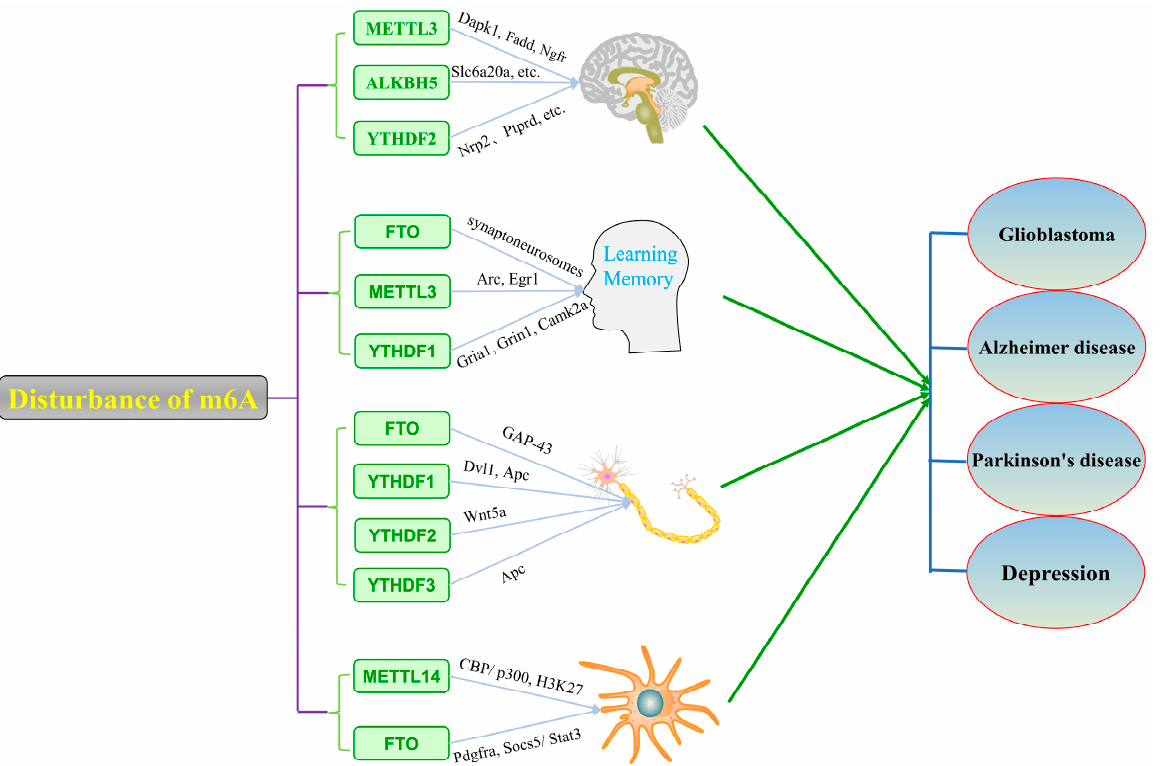
Figure 2. Disorders of m6A modification leads to dysfunction of the central nervous system and related diseases. Abbreviations: Slc6a20a (Solute carrier family 6 (neurotransmitter transporter), member 20A); Nrp2 (Neuropilin 2); Ptprd (Protein tyrosine phosphatase receptor type D); Arc (Activity regulated cytoskeleton associated protein); Egr1 (Early growth response 1); Gria1 (Glutamate ionotropic receptor AMPA type subunit 1); Grin1 (Glutamate ionotropic receptor NMDA type subunit 1); Camk2a (Calcium/calmodulin dependent protein kinase II alpha).